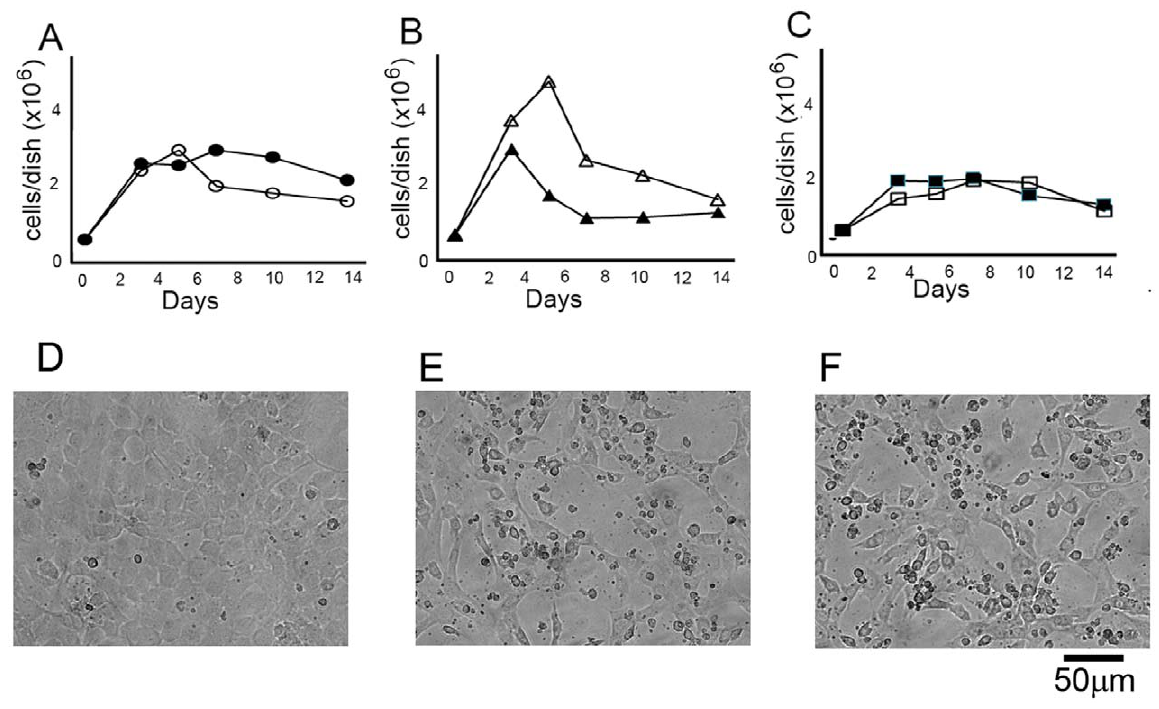
Figure 6. Tolerance of MEFs expressing exogenous SWAP-70s to nutrient starvation. Cells were cultured at a density of 2 6 10 5 cells in 6- cm dishes and cultured without medium replacement. A–C, Numbers in each dish were counted. D–F, Photographs of the cells when nutrient starved. A, parental MEFs (closed circles) and MEFs expressing wild-type SWAP-70, SWAP-70-5, (open circles) are shown. B, MEFs expressing SWAP-70- 374: SWAP-70-374-2 (closed triangles) and SWAP-70-374-24 (open triangles). C, MEFs expressing SWAP-70-374m1: SWAP-70-374m1-12 (closed squares) and SWAP-70-374m1-14 (open squares). The standard deviations for each point were less than 4%. D, SWAP-70-5 after cultivation for 7 days. E, SWAP-70-374-2 after cultivation of 5 days. F, SWAP-70-374-24 after cultivation for 7 days. Error bars indicate standard deviation. doi:10.1371/journal.pone.0014180.g006 membrane translocation of the protein to the plasma membrane, Expression of this protein slows down the growth of the cells and the PtdIns(3,4,5)P 3 binding activity appears to be still required for makes them flatter than the parental cells. Saturation cell density transformation of MEFs. Interestingly, SWAP-70-374m1, which is was also lower than that of the parental cells. It is likely that incapable of binding to PtdIns(3,4,5)P 3 , inhibited growth of MEFs. SWAP-70-374m1 may be in an activated conformation that can